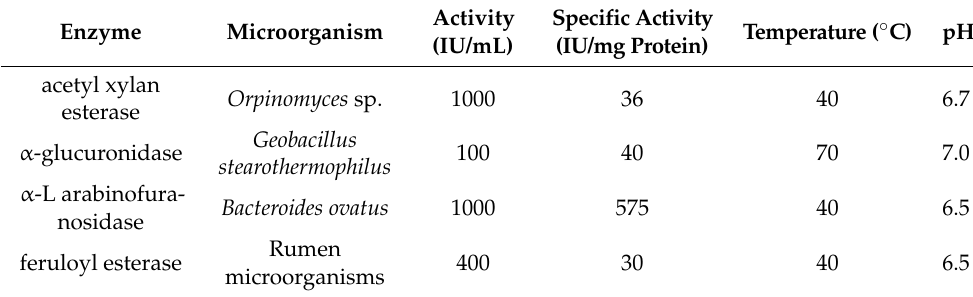
Table 3. Commercial auxiliary enzymes activity and optimum temperature and